Question: Write the caption for this figure.
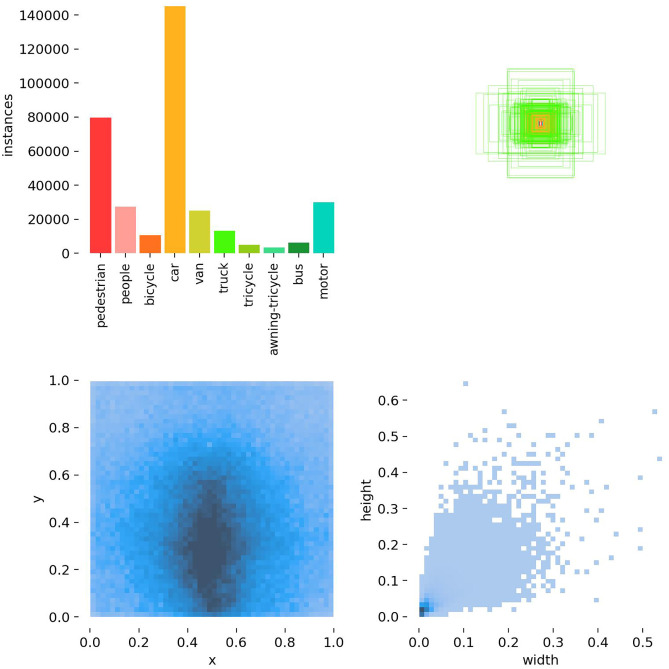
Answer: Datasets label distribution map.